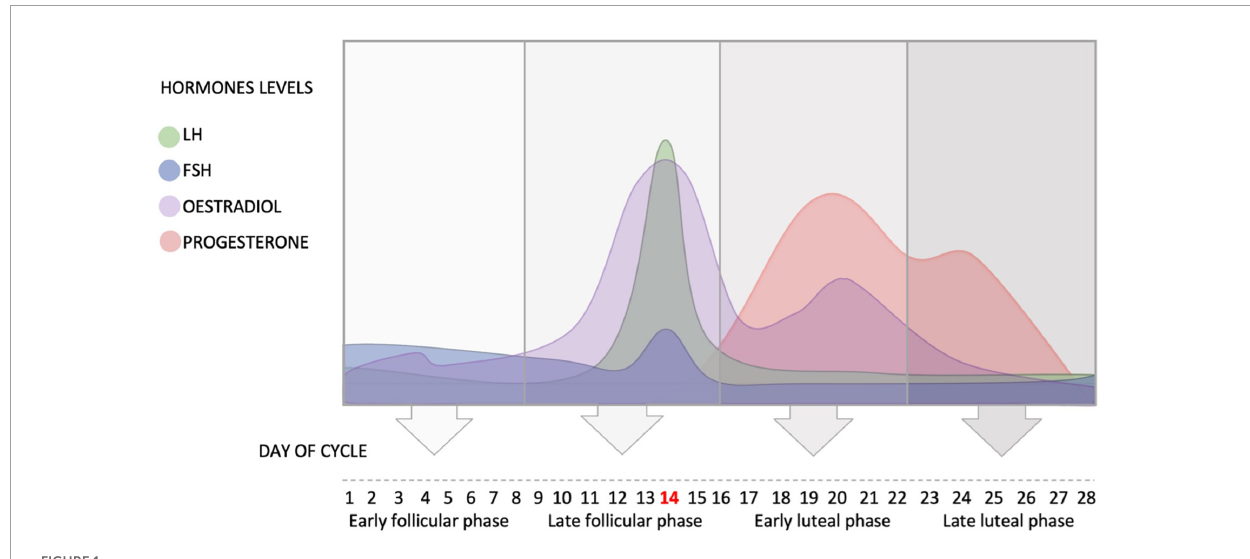
FIGURE1 Schematic representation of the fluctuation of the hypothalamus and ovarian hormones during the average ovarian cycle, and the four phases of the cycle. FSH, follicle stimulating hormone; LH, luteinizing